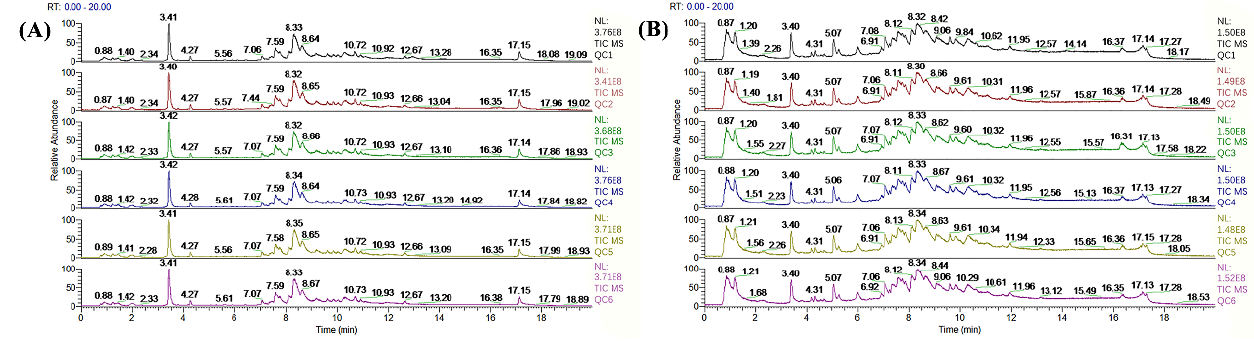
Figure 3. Metabolite profiles of QC samples. ( A ) positive ion mode; ( B ) negative ion model.